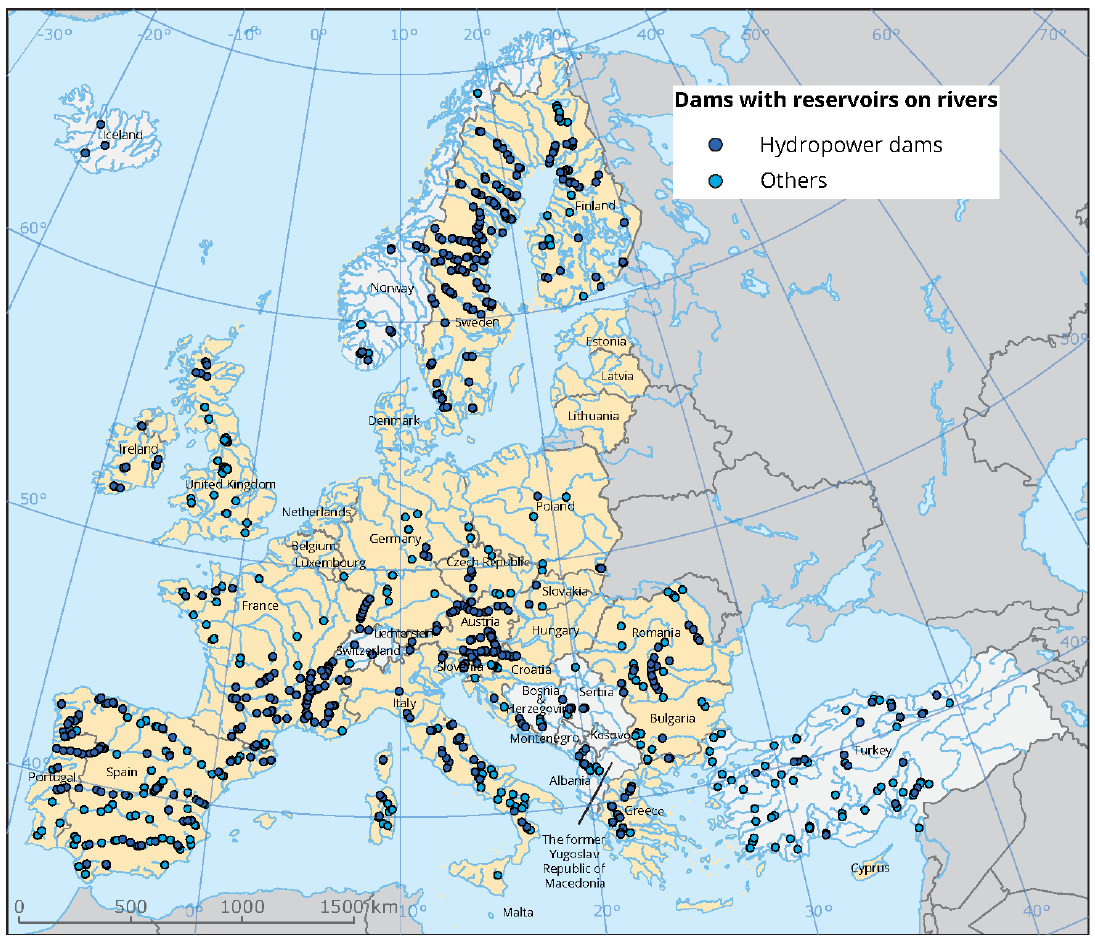
Figure 1. Dams on larger rivers in Europe. Hydropower stations and non-powered dams (NPDs). Source: European Environment Agency (EEA). Available online at: